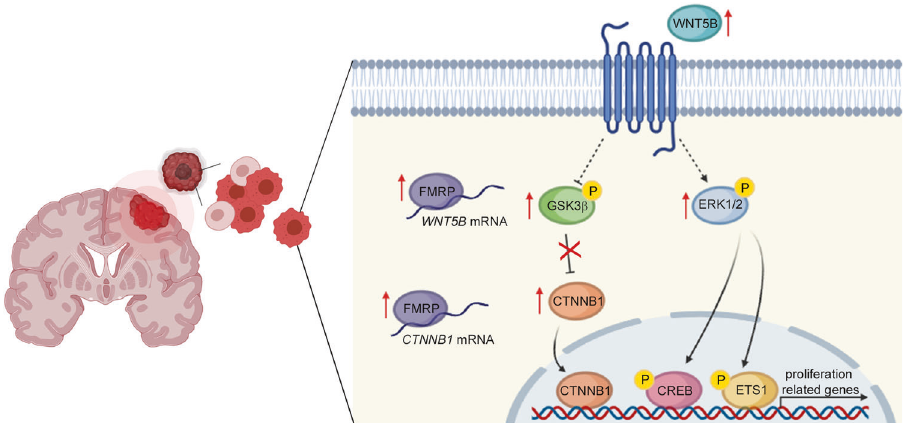
Fig. 6 Molecular model of FMRP-mediated regulation in GSCs. FMRP is upregulated in GSCs and regulates the expression of WNT5B and CTNNB1 mRNAs, pivotal in stem cells maintenance. Increased levels of FMRP lead to the aberrant activation of the WNT canonical and non- canonical signalling pathways affecting the transcription of genes related to cell